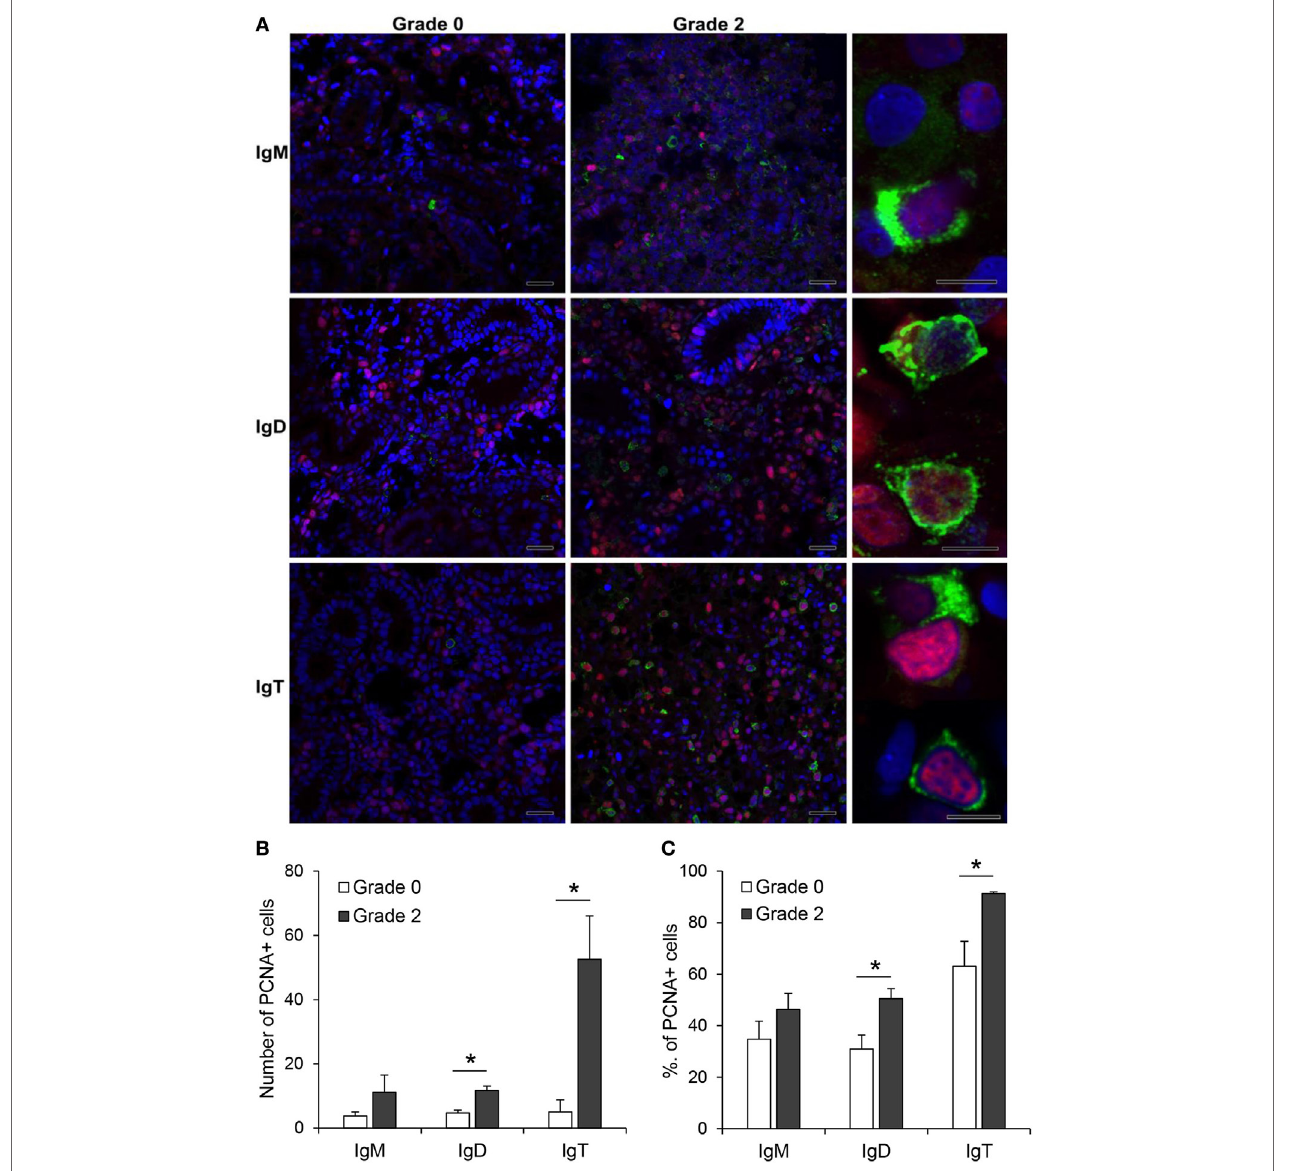
FigUre 6 | Proliferation of IgM + , IgD + , and IgT + cells in kidney. (a) Confocal microscopic images of rainbow trout kidney sections infected with Tetracapsuloides bryosalmonae exhibiting different swelling grades were labeled with anti­immunoglobulin (Ig) M, anti­IgD, or anti­IgT (green) in combination with anti­proliferating cell nuclear antigen (PCNA) (red). All sections were also counterstained with DAPI (blue). Representative images for grade 0 and grade 2 are shown (scale bars = 20 µm) along with representative images from grade 2 kidneys at higher magnification (right; scale bars = 5 µm). Note that in non­proliferating cells, nuclei appear blue whereas they appear violet in proliferating cells. Mean number (B) and mean percentage (c) of proliferating IgM + , IgD + , and IgT + cells were calculated in 10 digital fields (400 × magnification) from 6 different individuals. Statistically significant differences ( P < 0.05) in proliferating IgM + , IgD + , and IgT + cells between grade 0 and grade 2 fish (analyzed by one­way ANOVA followed by two­tailed Student’s t ­test) are indicated with an